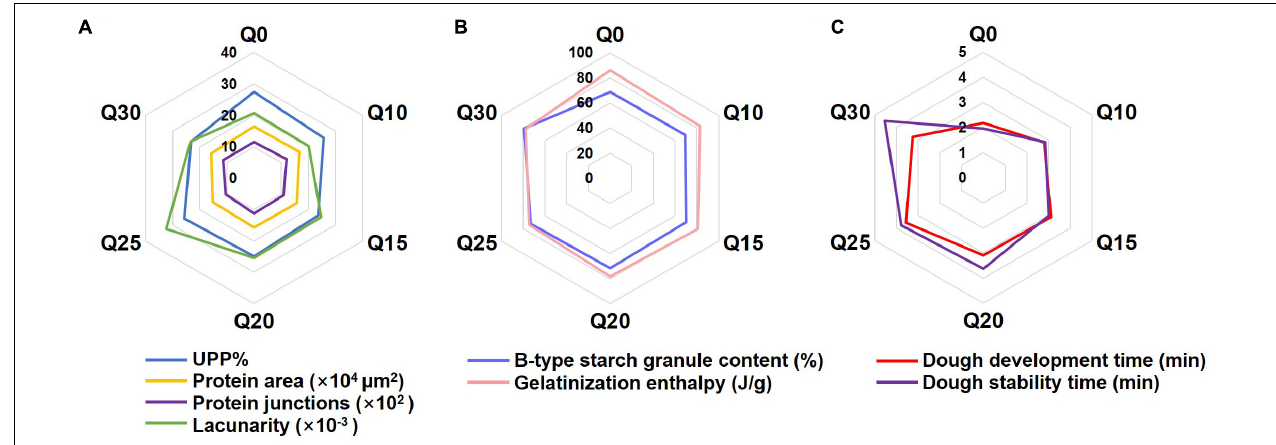
FIGURE 2 | The radar graphs of quality characteristics of wheat and quinoa reconstituted doughs. (A) Comparison of UPP%, protein area, protein junctions and lacunarity in wheat and quinoa reconstituted doughs. (B) Comparison of B-type starch granule content and gelatinization enthalpy in wheat and quinoa reconstituted doughs. (C) Comparison of dough development time and dough stability time in wheat and quinoa reconstituted doughs.